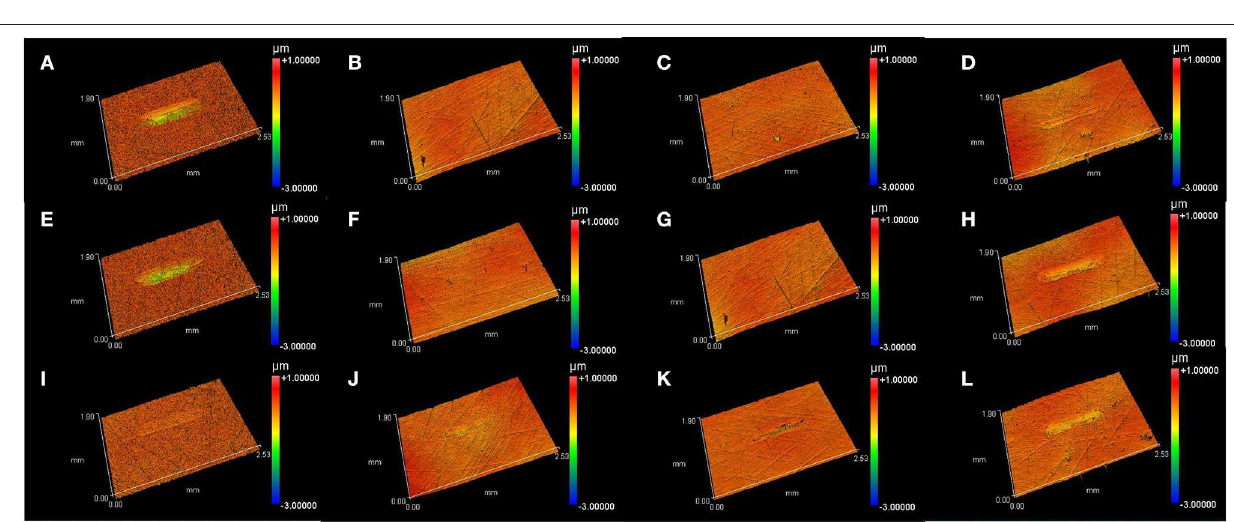
Frontiers in Chemistry |